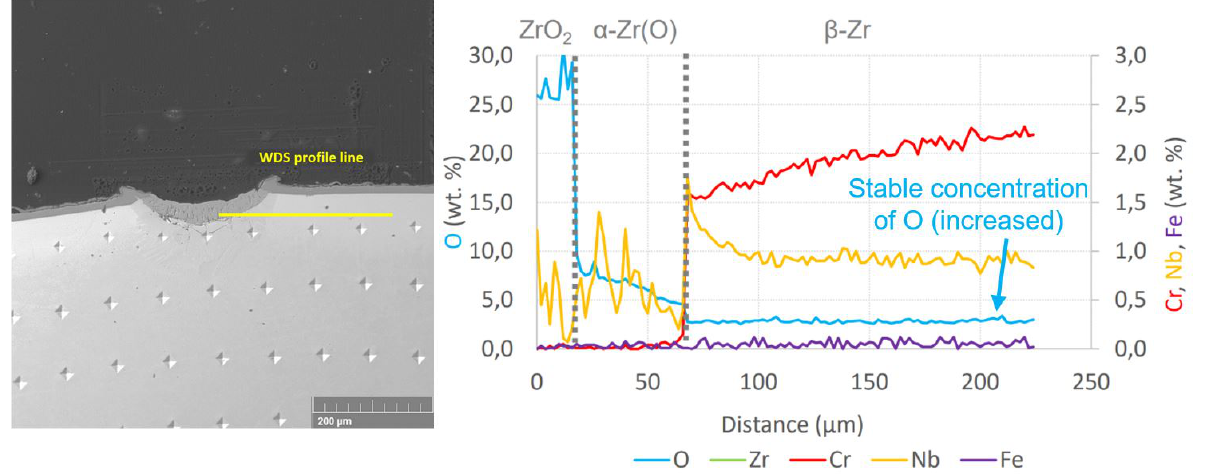
Figure 10. WDS profile measured parallel to the coating at a distance of 25 µm, 4,5 min HT